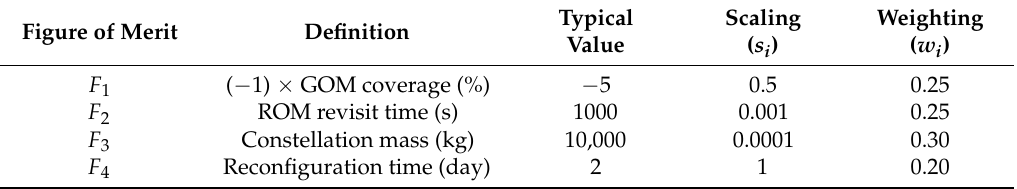
Table 11. Figures of merit, scaling and weighting factors in single-objective optimization. Figure